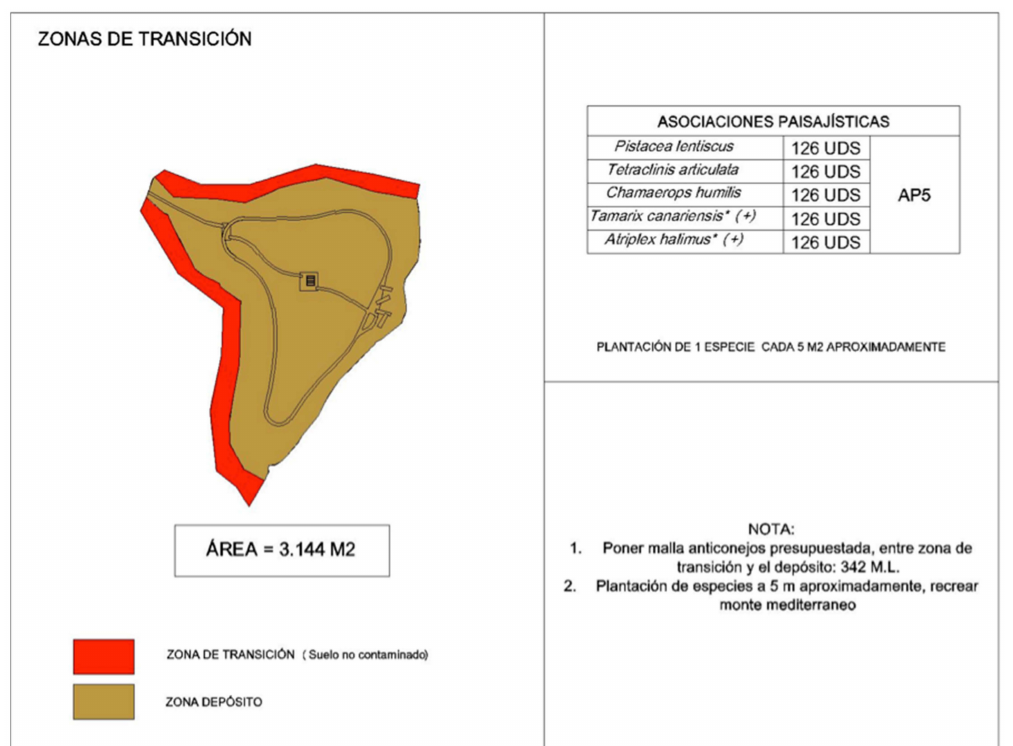
Figure A9. Planting map for the transition zone of Case Study